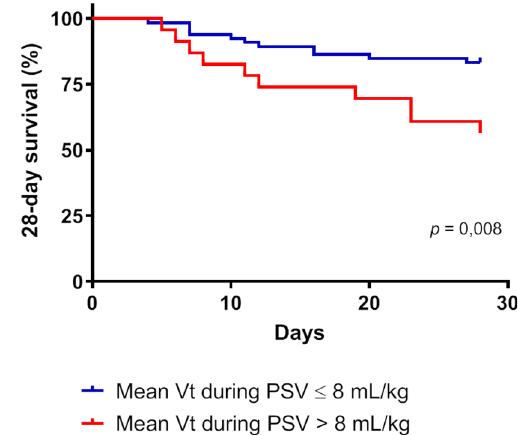
Fig. 1 Kaplan‑Meier estimate of the cumulative probability of survival according to the mean tidal volume (Vt)—lower of higher than 8